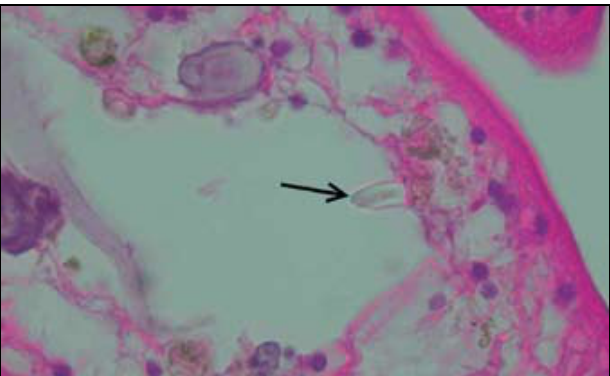
Fig. 2. Histological slide indicating the presence of a hydatid hooklet (arrow) (Figure by courtesy of the Division of Anatomical Pathology/NHLS, University of the